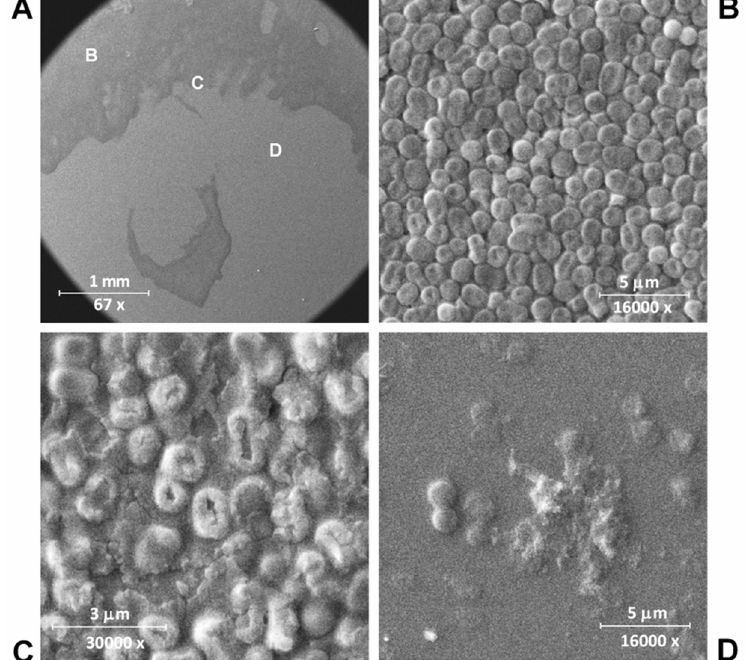
Figure 1. LysECD7-8his-mediated lysis of A. baumannii Ts 50-16 cells on plates. Scanning electron microscopy (SEM) images of the plate imprint of the bacterial lysis zone. ( A ) General view of the imprint, localization of B, С and D imprints is shown; ( B ) area with no cell lysis (control); ( C ) the edge of the lysis zone; ( D ) the deep lysis zone area. The bacterial lawn was treated for 16 h at 37 °C with 10 µL of LysECD7-8his at 1 mg/mL (10 µg in total) before fixation.